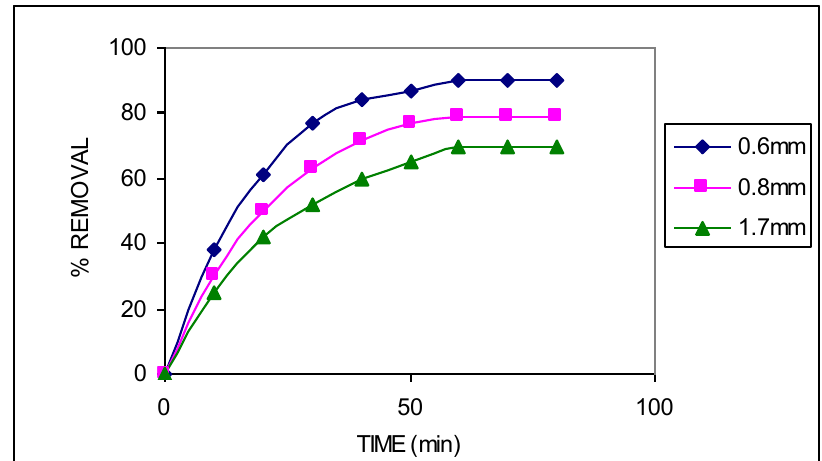
Figure 4. Relationship between particle size, % removal at different times.